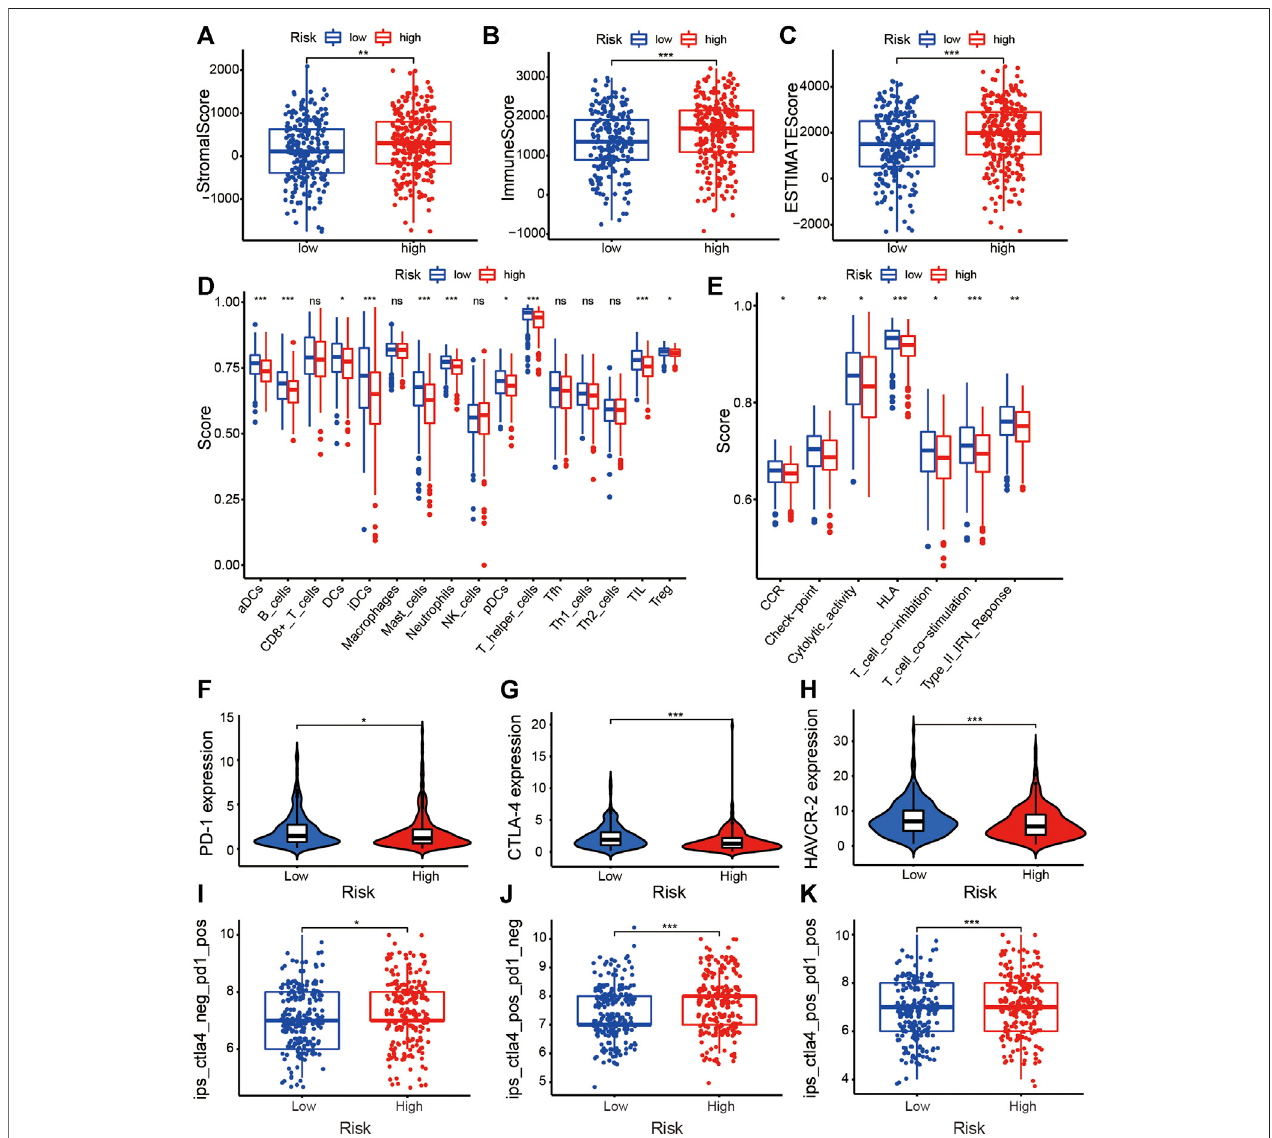
FIGURE 7 | Exploration of the tumor immunity and ICI ef fi cacy of the ARlncRNA signature. (A – C) The column diagrams reveal that low-risk group patients have a higher StromalScore (A) , ImmuneScore (B) , and ESTIMATEScore (C) . (D,E) The multi-boxplots show that patients in low-risk group have a higher abundance of aDCs, Bcells,DCs,iDCs,mastcells,neutrophils,pDCs,Thelpercells,TILs,andTregs (D) .Severalimmunepathways,includingCCR,checkpoint, cytolyticactivity, HLA,Tcell co-inhibition, T cell co-stimulation, and type II IFN response were enriched in low-risk patients (E) . (F – H) The violin plots indicate that high-risk score correlated signi fi cantly negatively with high PD-1 (F) , CTLA-4 (G) , and HAVCR-2 (H) expression, revealing low-risk patients are more applicable for ICIs treatment. (I – K) The violin plotsvalidatetheresultsabovethatregardlessofwhetheritisaPD-1blockeralone (I) ,aCTLA-4blockeralone (J) ,oracombinationofthetwo (K) ,theef fi cacyofpatients with low-risk is better than that of high-risk